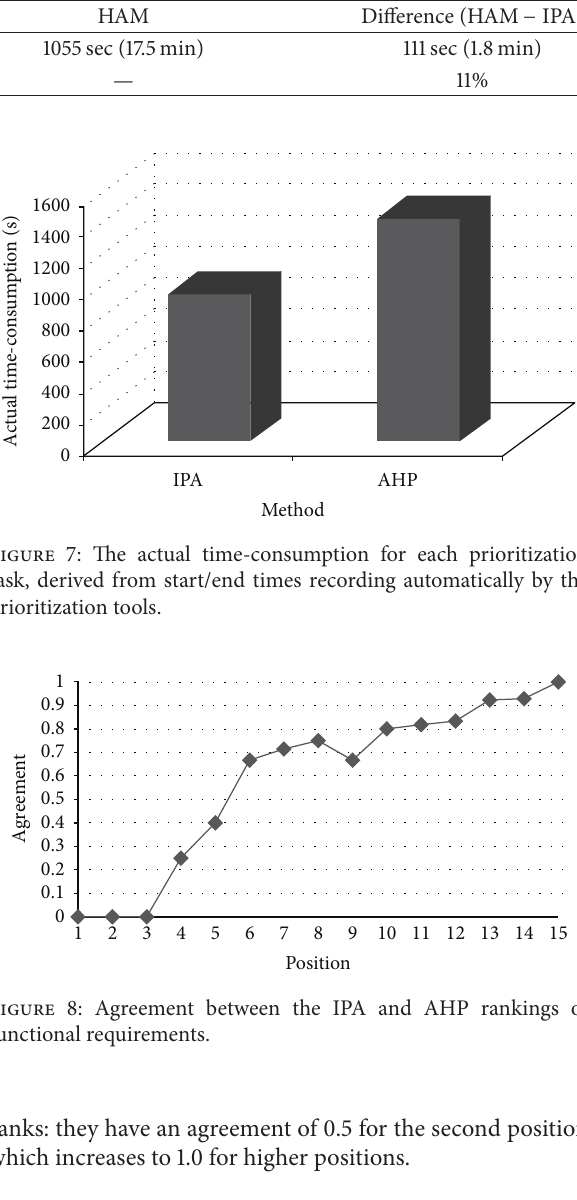
Table 9: Actual time-consumption for the prioritization.